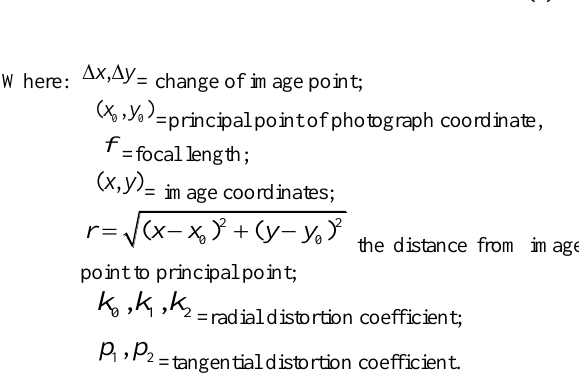
LCS and the collected facade texture, researches the three- dimensional modeling method. The experimental results show that this method is simple, reliable and 3d result is lifelike and